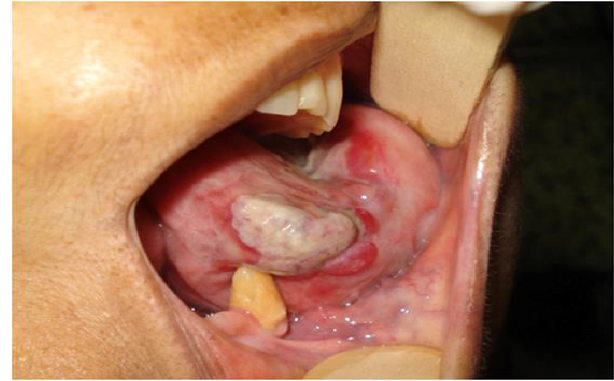
Fig. 2. Extraoral clinical image of the patient. An exophytic and erythematous lesion with pseudomembranous plaques. The patient provided a conventional radiograph that showed a radiopaque image that occupied the jaw's body and ascending branch (Fig. 3). CT scan of the head showed a hypodense mass on the left mandible, with vestibular bone cortical fenestration (Fig. 4).